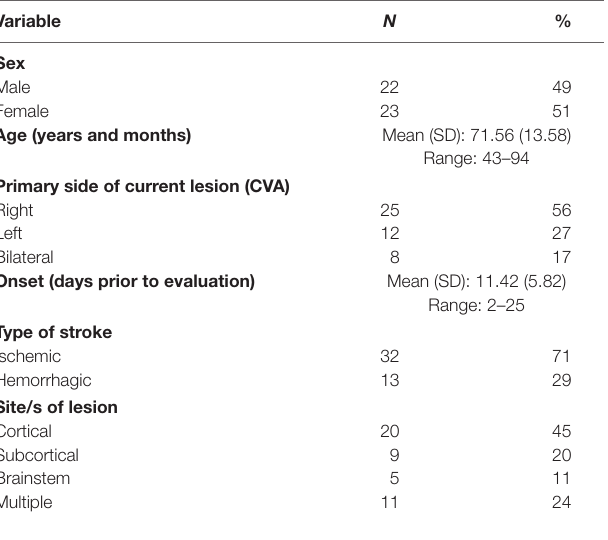
TaBle 1 | Participant demographic and stroke-specific characteristics ( n = 45).